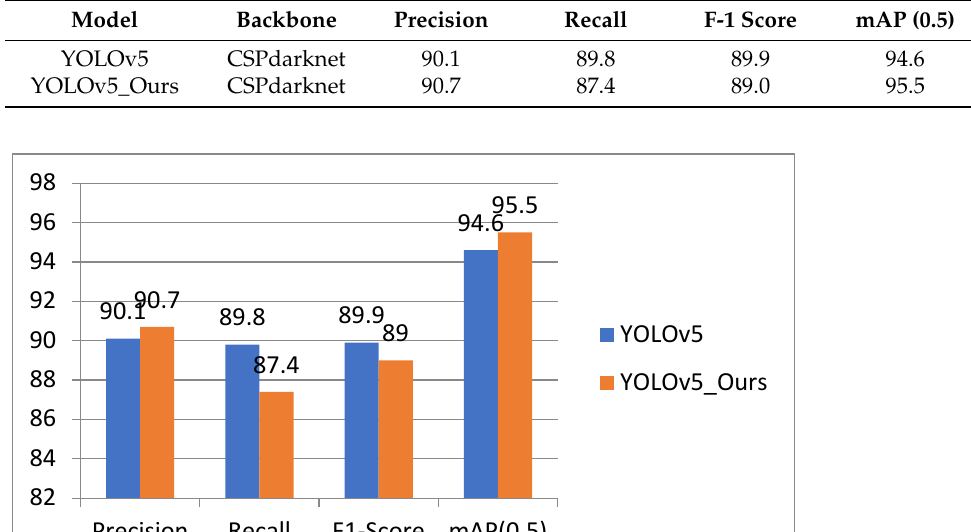
Table 2. Comparison table of best performance by models.